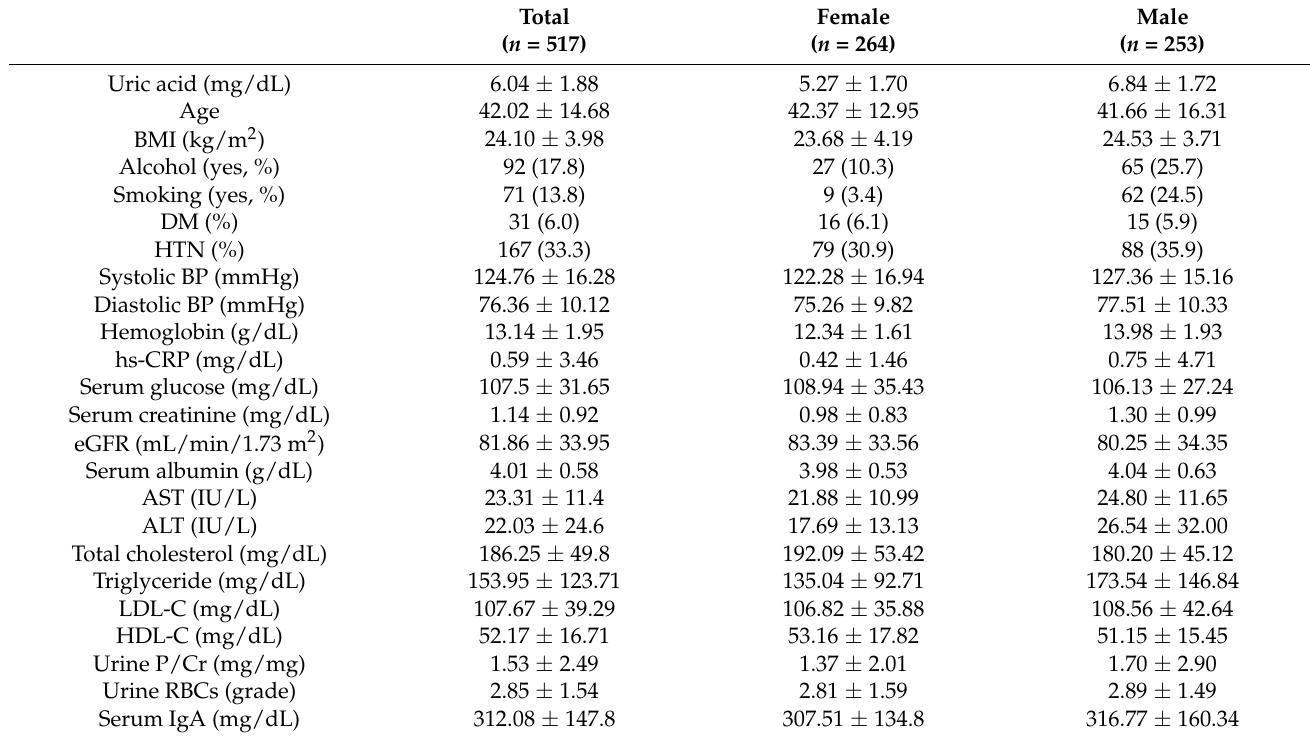
Figure 2. Distribution of serum uric acid by sex. (A ) Median serum UA level was 5.27 mg/dL in females. ( B ) Median serum UA level was 6.84 mg/dL in males. Table 1. Baseline clinical variables of the total patient and each sex group at the time of renal